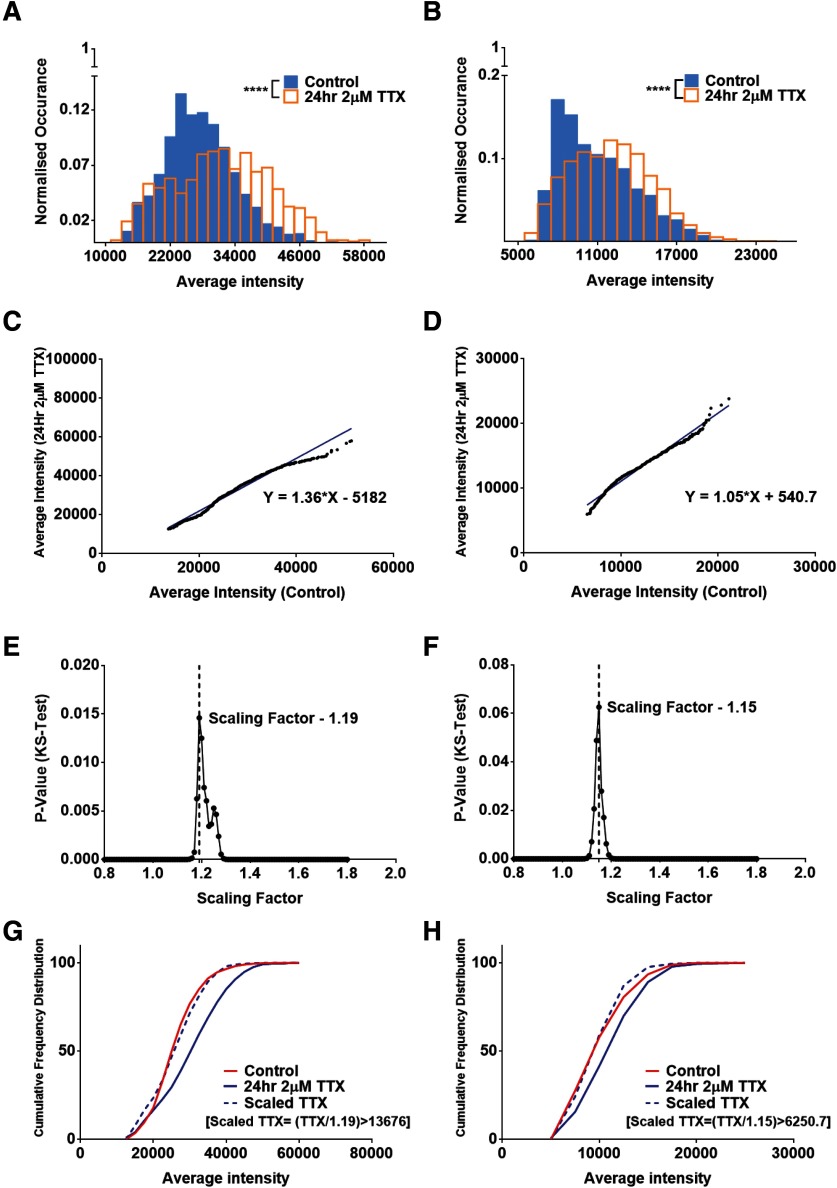
Multiplicative scaling of synaptic scaffolding molecules during homeostatic scaling in rodents. A, B, Histogram comparing the average intensity of Shank2 per puncta in the control and TTX conditions showed positive scaling after 24 h of treatment for both mouse (A) and rat (B) cultures (n = 1889 and 826 synapses for mouse and 1592 and 1821 synapses for rat, for control and TTX dataset, respectively, p < 10−6, KS test). C, D, A total of 800 random average intensity data points were chosen, rank ordered, and plotted to provide a scaling equation for mouse (C; y = 1.36x – 5182) and rat (D; y =1.05x + 540.7) cultures. E, F, The scaling factor providing the maximum p value between control and scaled-TTX datasets was chosen as the multiplicative scaling factor for both mouse (E; 1.19, p = 0.015, KS test) and rat (F; 1.15, p = 0.063, KS test) cultures. G, H, A cumulative frequency distribution was plotted for control, TTX, and the scaled-TTX (calculated with the help of the scaling factor) datasets for the mouse (G) and rat (H) showing no significant difference between the control and the scaled-TTX dataset. For comparison of multiplicative scaling of other synaptic scaffolding molecules, please refer to Extended Data Figure 2-1. A detailed analysis of sampling efficiency for calculating multiplicative scaling factor and significance of scaling factors are detailed in Extended Data Figures 2-2, 2-3, respectively. Analysis referring to accuracy of scaling in homeostatic plasticity is shown in Extended Data Figure 2-4.